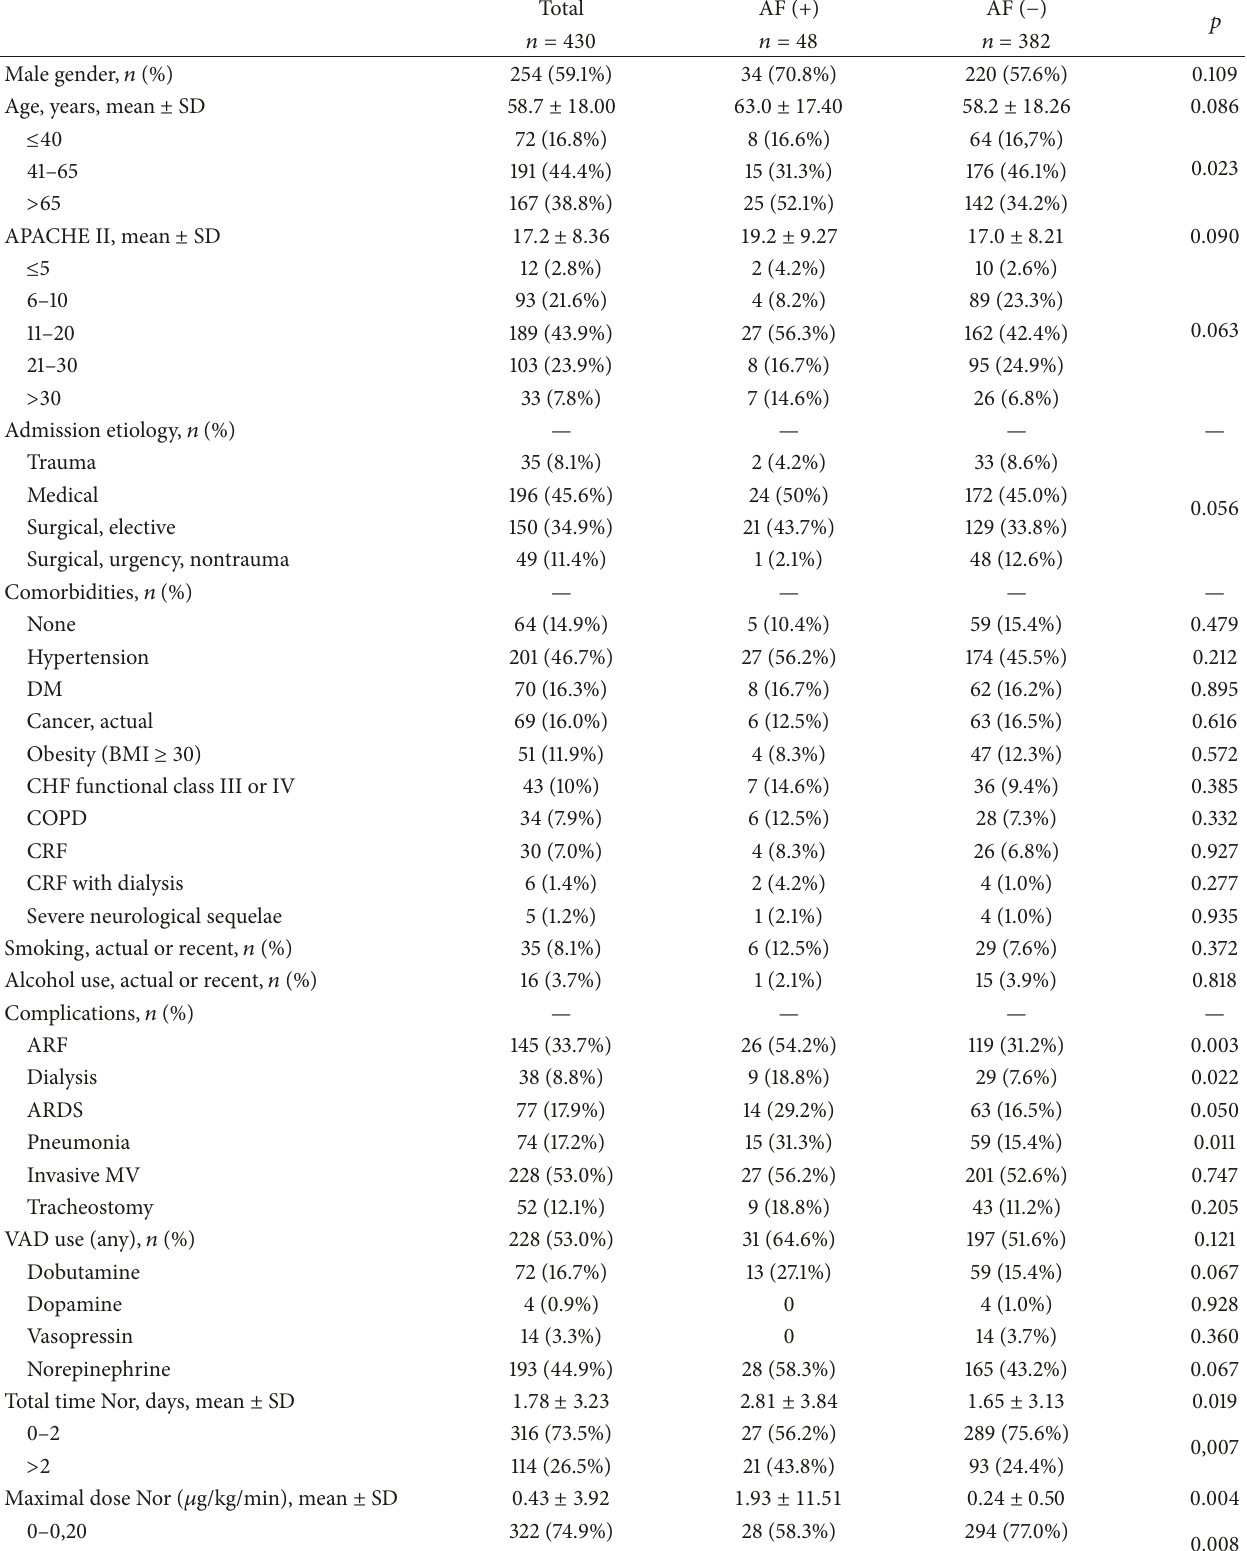
Table 1: Demographic, clinical, and outcome